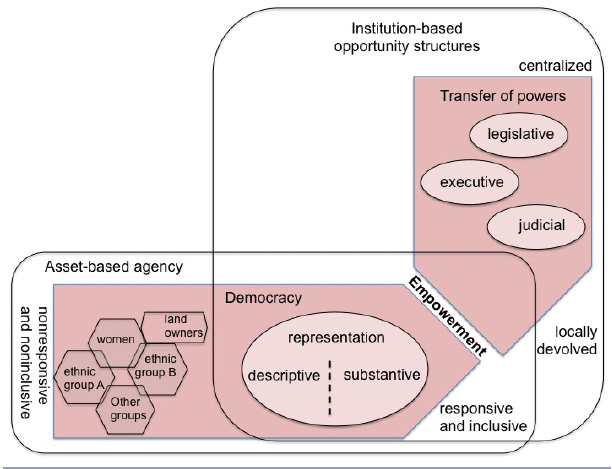
Fig. 1 . Empowerment as the intersection of asset-based agency and institution-based opportunity with transformative processes of democracy and transfer of powers, respectively. Agency is ultimately an attribute of individuals but tends to be applied to groups. Multiple, overlapping ways of grouping individuals may apply (hexagon labels are illustrative) and may be relevant to understanding how inclusive representation is of socially differentiated groups of actors, both descriptively and substantively. Democracy is seen as a critical means of achieving